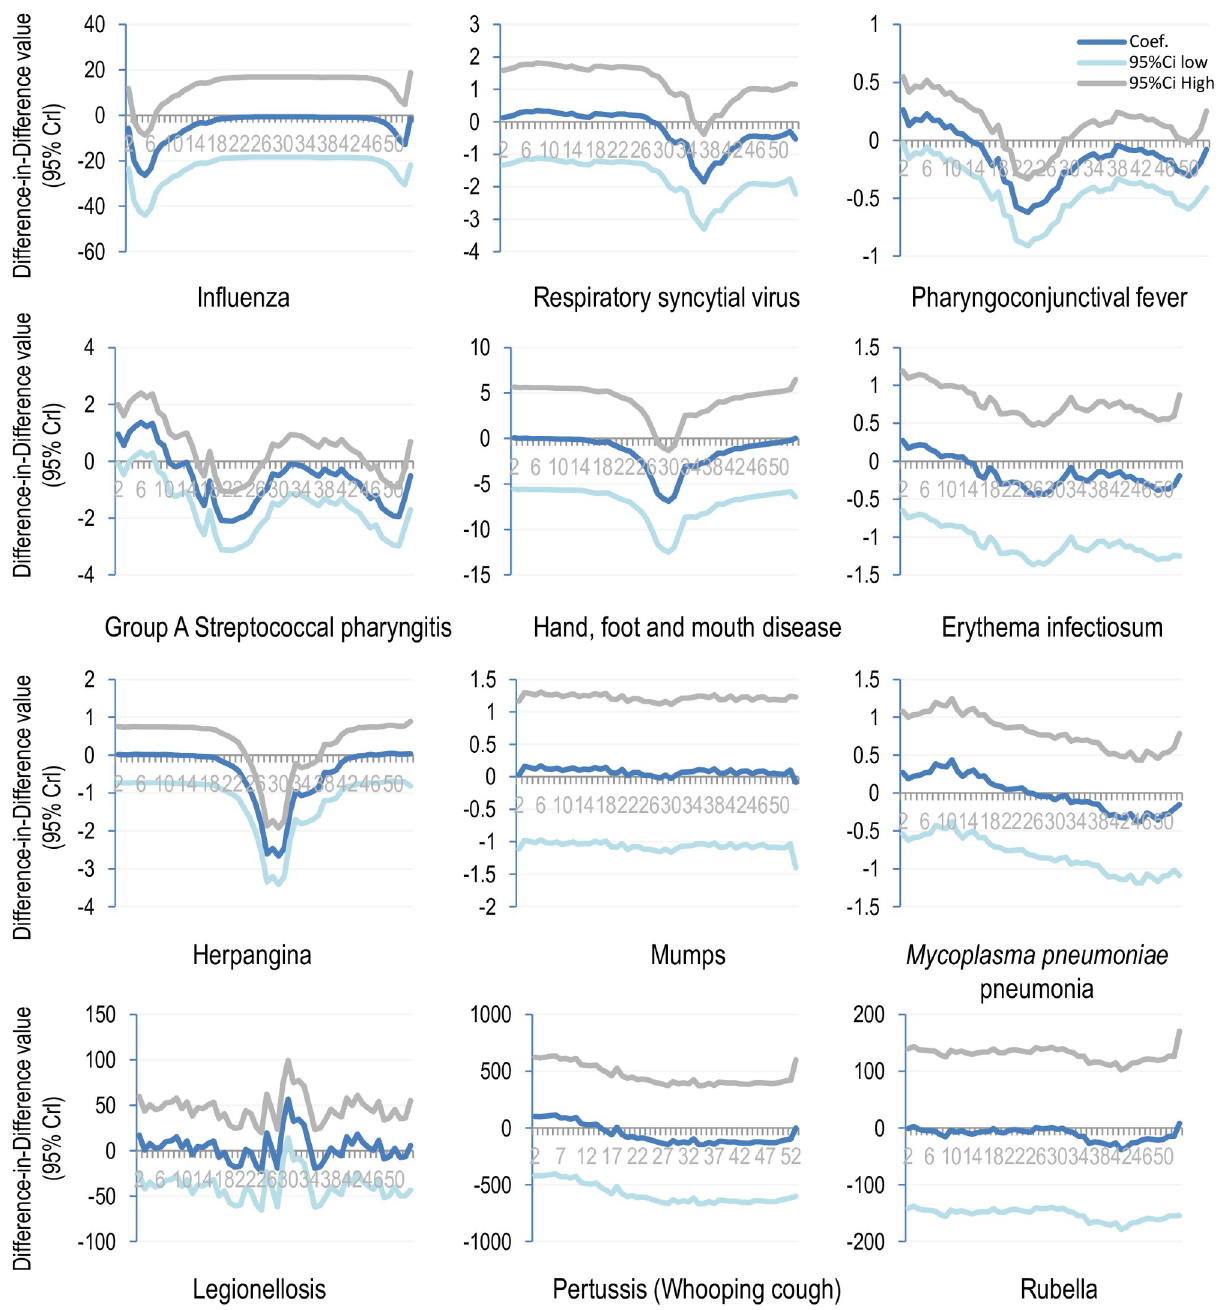
Fig 4. Difference-in-differences value in 2020 vs. that in 2015–2019 (95% credible interval for droplet transmitted disease). A negative 95% credible interval indicates fewer cases in the 2020 than in the 5 previous years (p < 0.05). Ctrl: credible interval.